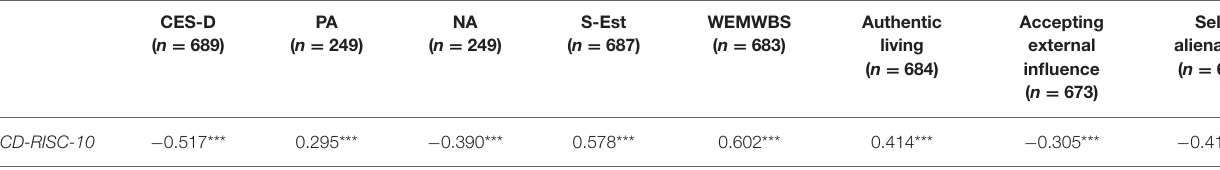
CES-D PA NA S-Est WEMWBS ( n = 689) ( n = 249) ( n = 249) ( n = 687) ( n = 683)